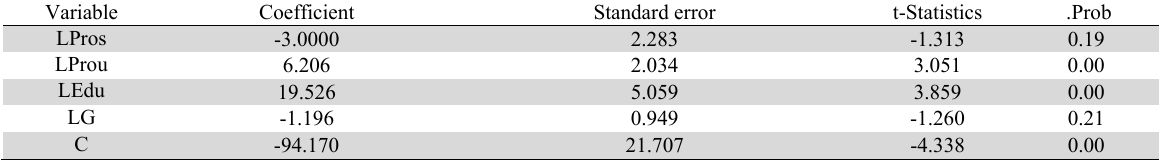
Investigating the long-run relationship between the productivity of skilled and unskilled workers and the level of wages without trends Variable Coefficient Standard error